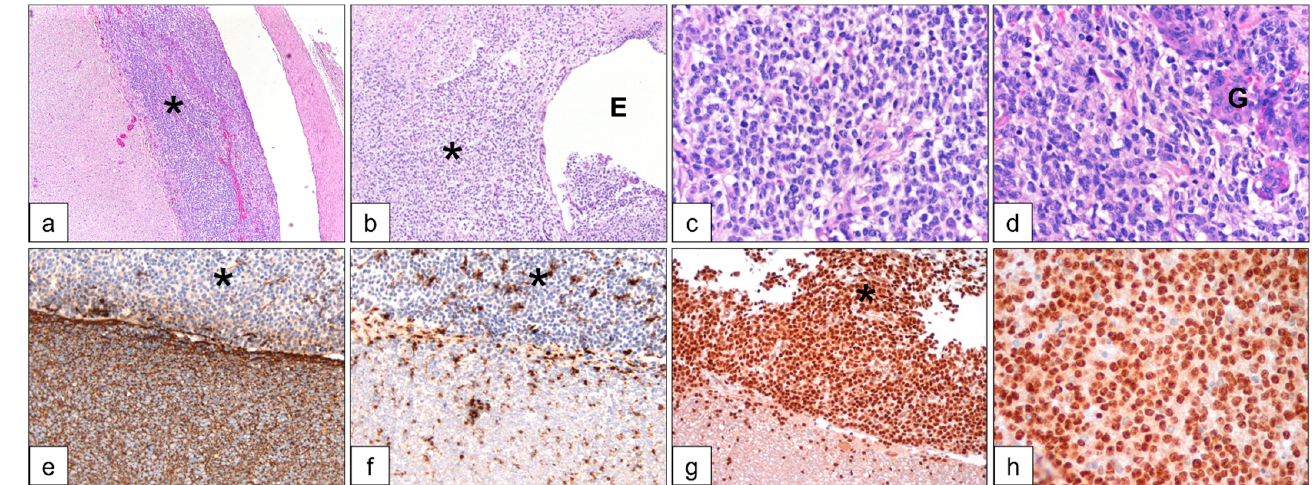
Figure 2. Case 3, histological and immunohistochemistry findings of the dissected neoplastic tissue in the spinal cord. H&E stained slides ( a – d ) show neoplastic cells (*) at the meningeal area and at the ependymal canal ( E ), multifocally forming glomeruloid bodies ( G ). By immunohistochemistry, neoplastic cells (*) were negative for GFAP ( e ) and Iba1 ( f ), while positive for Olig2 ( g , h ).